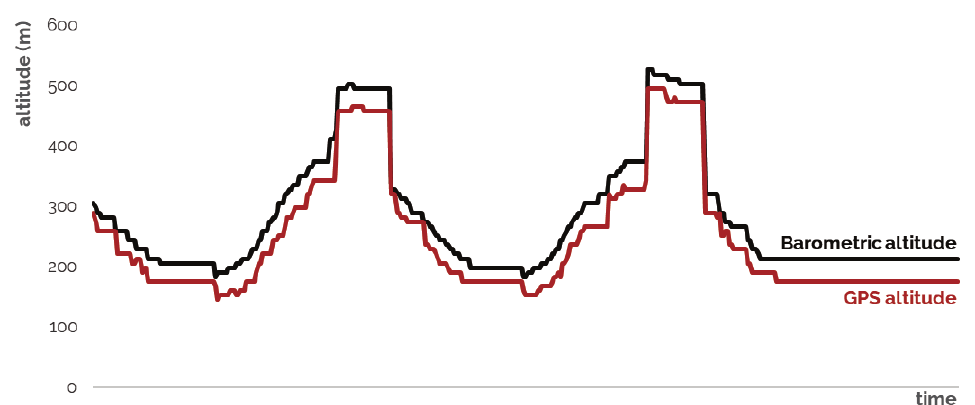
Figure 5. Th e two reported altitudes (barometric and GPS) both vary in their accuracy. In this case, the GPS altitude is lower than the barometric altitude throughout the fl ight, with the two altitudes occasionally